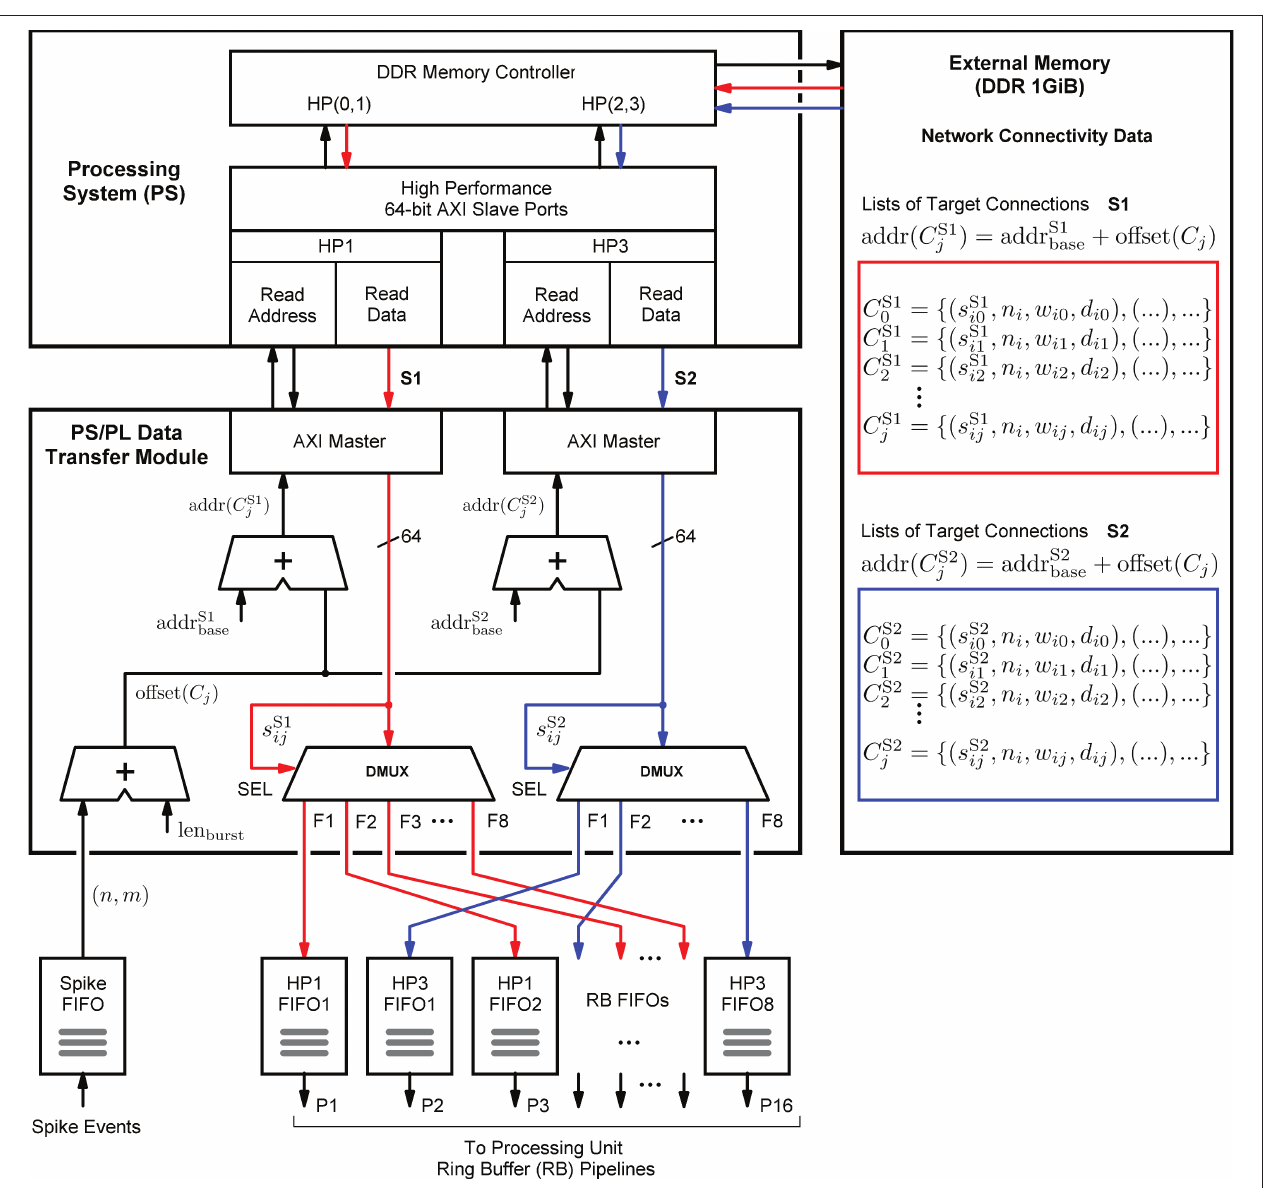
FIGURE 8 | Presynaptic data distribution. Upon the arrival of a spike event, the presynaptic data is read from the external memory in two independent parallel data streams S1 and S2, indicated by the red and blue arrows, and distributed to the RB FIFOs by the demultiplexers (DMUX). While the Processing System (PS) performs the external storage operations bypassing the APU (not shown in the figure), the PS/PL Data Transfer Module controls the two AXI data streams and the high-performance ports HP1 and HP3 through which it connects to the PS. It calculates the memory addresses of two lists, C S1 j and C S2 j which constitute the two data streams, that is, the presynaptic data associated with the neuron that has emitted the spike. This data is stored in two different memory regions, marked by the red and blue boxes. Figure 8 . The two high-performance ports are capable of working in parallel and independently of one another, while for example, the ports HP0 and HP1 would share the same PS resources, hindering full